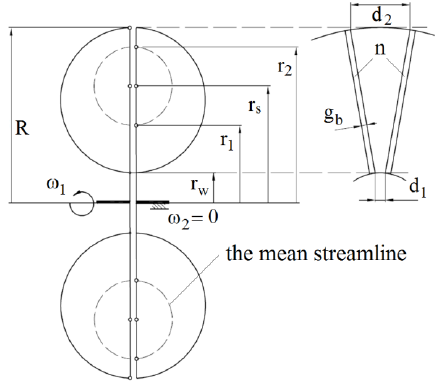
Figure 2. HB geometry for calculations (refer to Table 1). Table 1. PHB data.